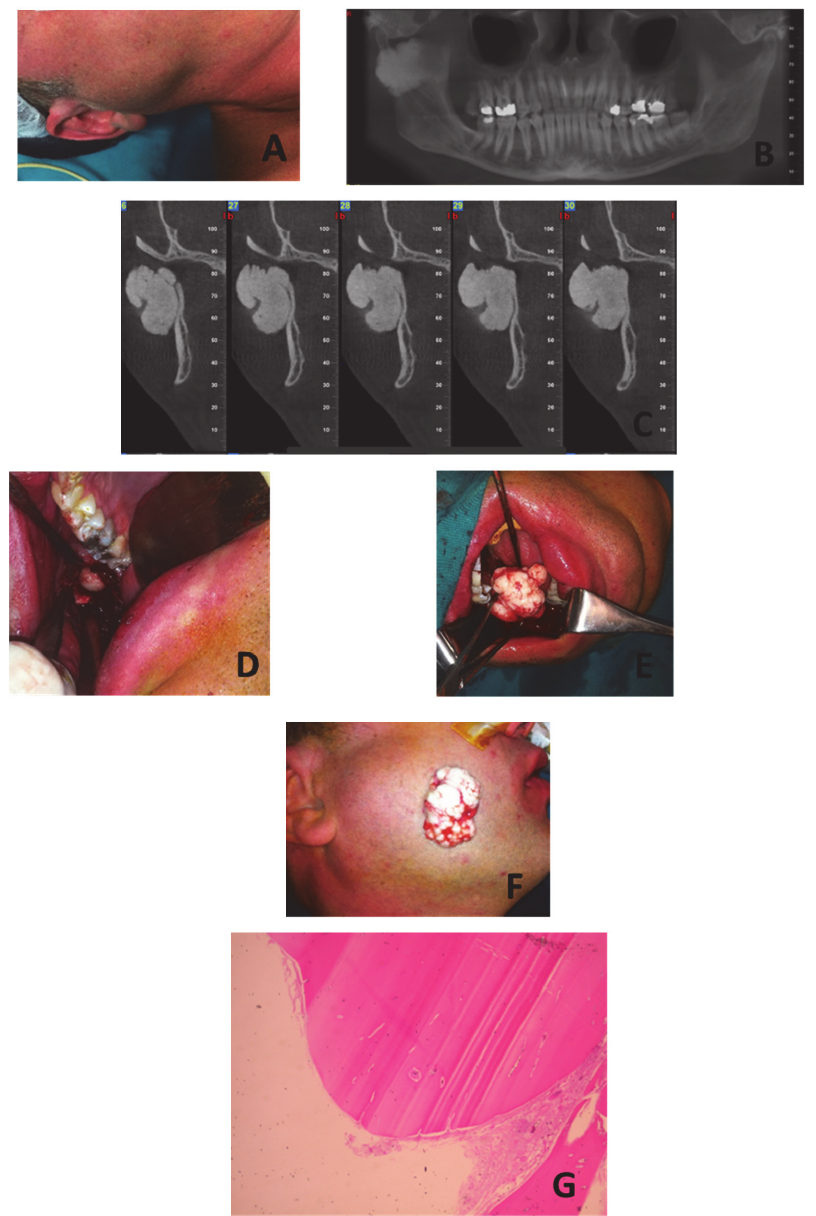
Figure 1. ( A ) Extra-oral swelling at the right pre-auricular area; ( B ) Panoramic X-ray showing a radiopaque well-circumscribed lesion at the area of the right mandibular condyle; ( C ) Coronal view of CT showing the lesion in relation to the ramus; ( D ) Intra-oral exposure of the osteoma; ( E ) Osteoma after detachment from the mandibular condyle; ( F ) Complete removal of the osteoma; ( G ) Dense compact bone with well-defined borders H & E X25.